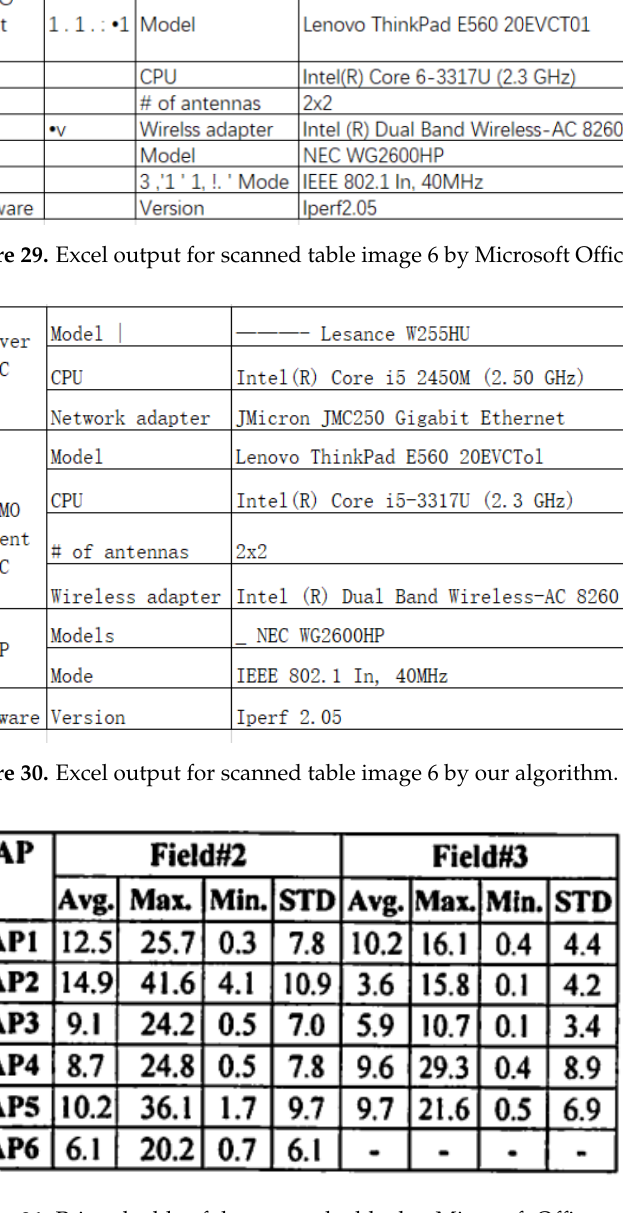
Figure 31. Printed table of the scanned table that Microsoft Office cannot